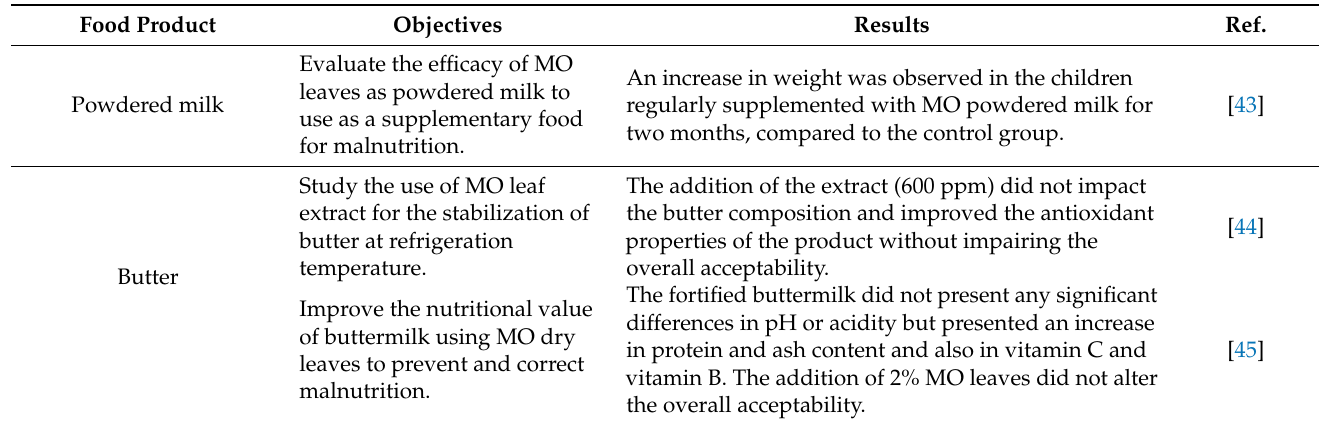
Table 1. Studies on the incorporation of Moringa oleifera leaves on dairy